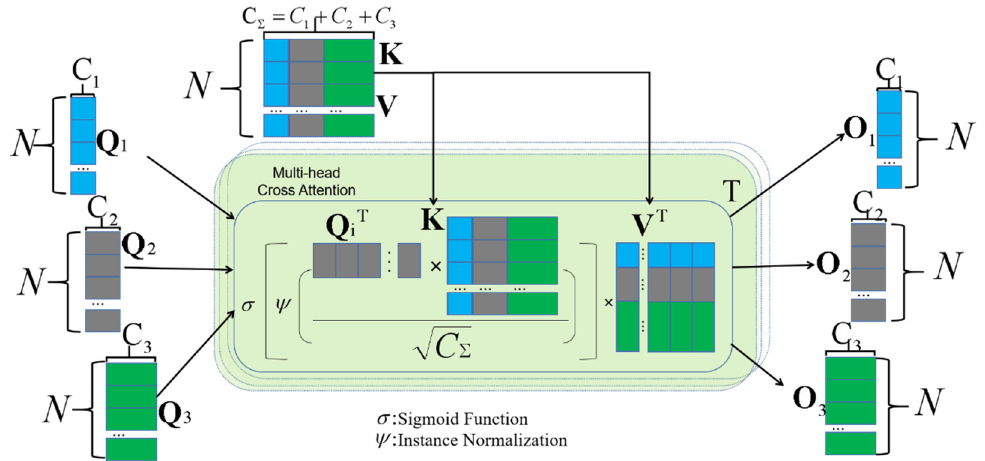
Figure 2. Multi-head cross